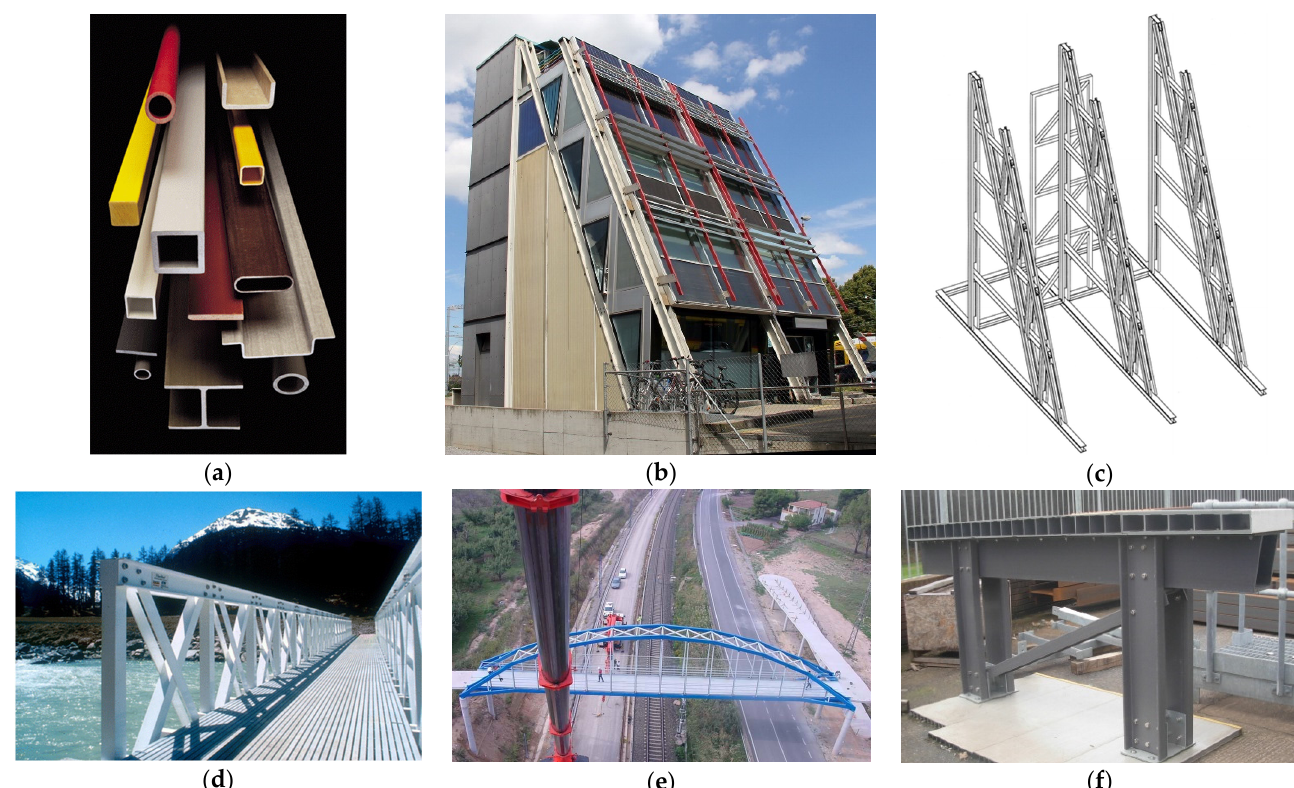
Figure 1. Use of FRP in Structural Engineering ( a ) Standard pultruded FRP shapes [4–6]; ( b ) GFRP Eyecatcher Building Basel, Switzerland, 1998 [9,17]; ( c ) Eyecatcher Building-three frame detail [17]; ( d ) Pontresina truss bridge, Switzerland, 1997 [17,18]; ( e ) 38 m span Lleida footbridge, Spain, 2004 (Courtesy Fiberline [4]); ( f ) GFRP platform with bolted joints (image by Jawed Qureshi with permission from Access Design and Engineering Telford UK).